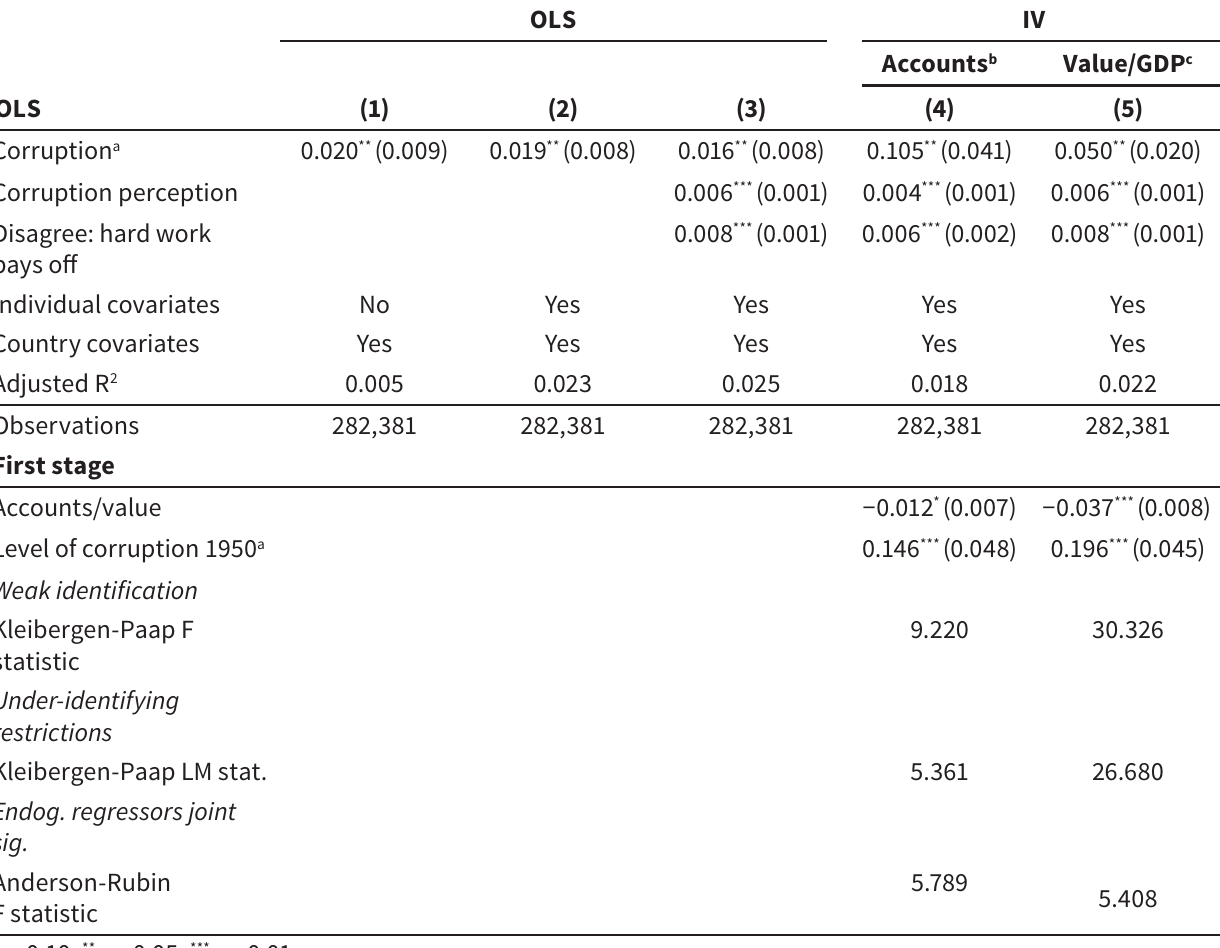
Effect of level of corruption on plans to emigrate in the next 12 months OLS